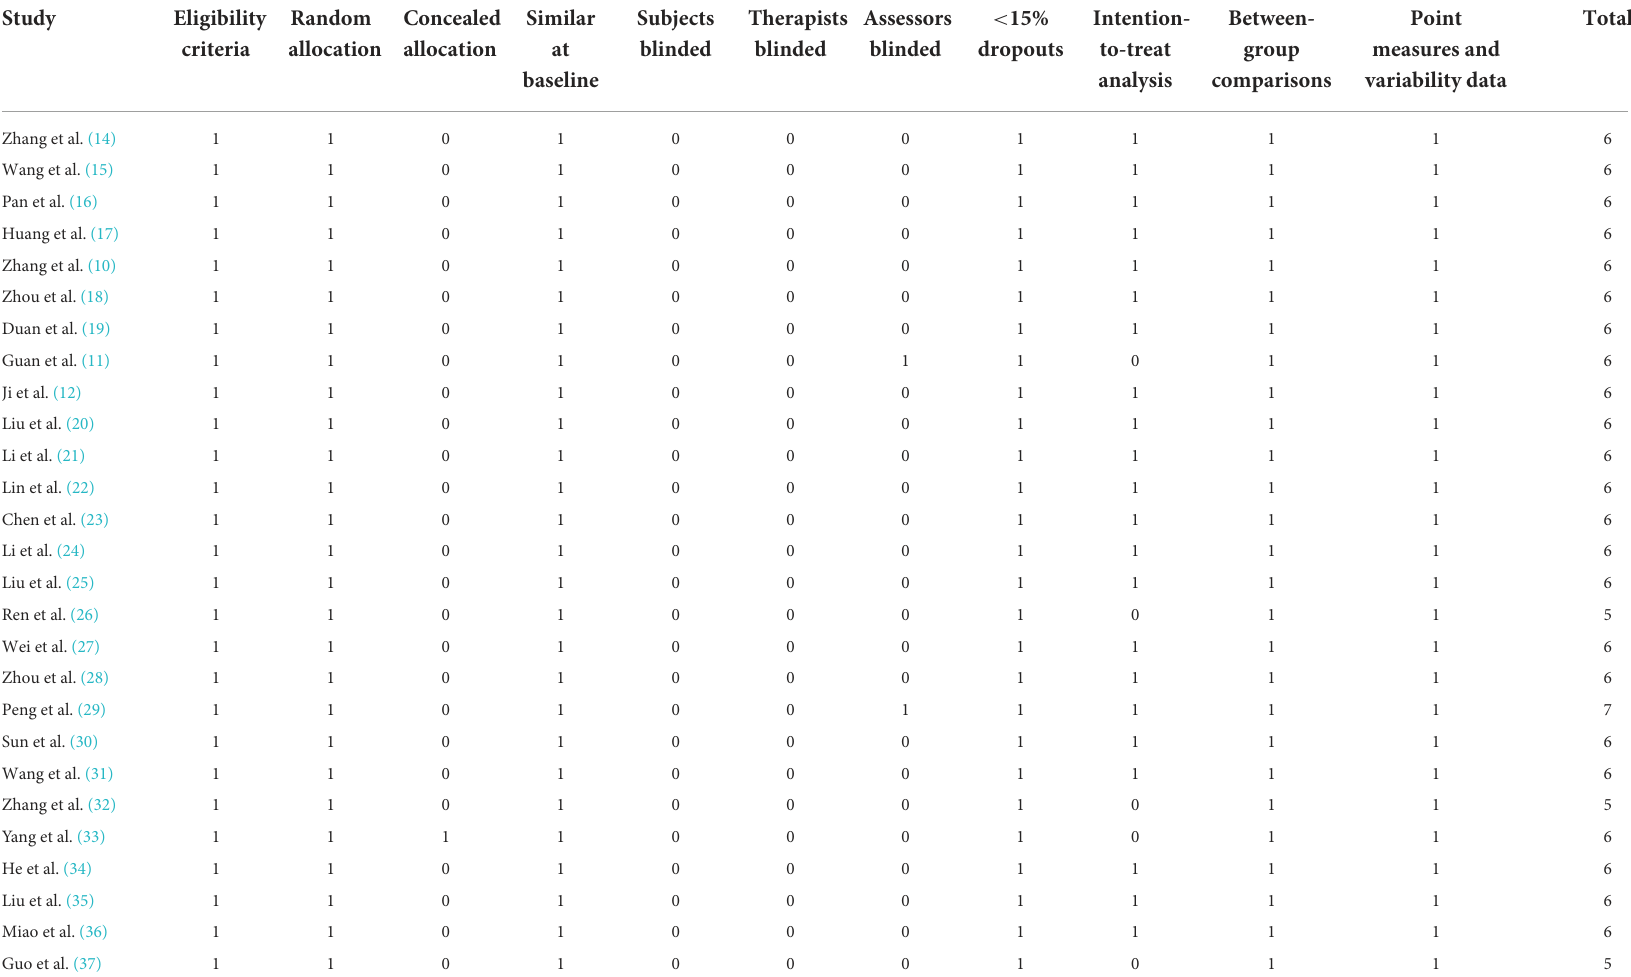
TABLE 2 PEDro scale of quality for the included